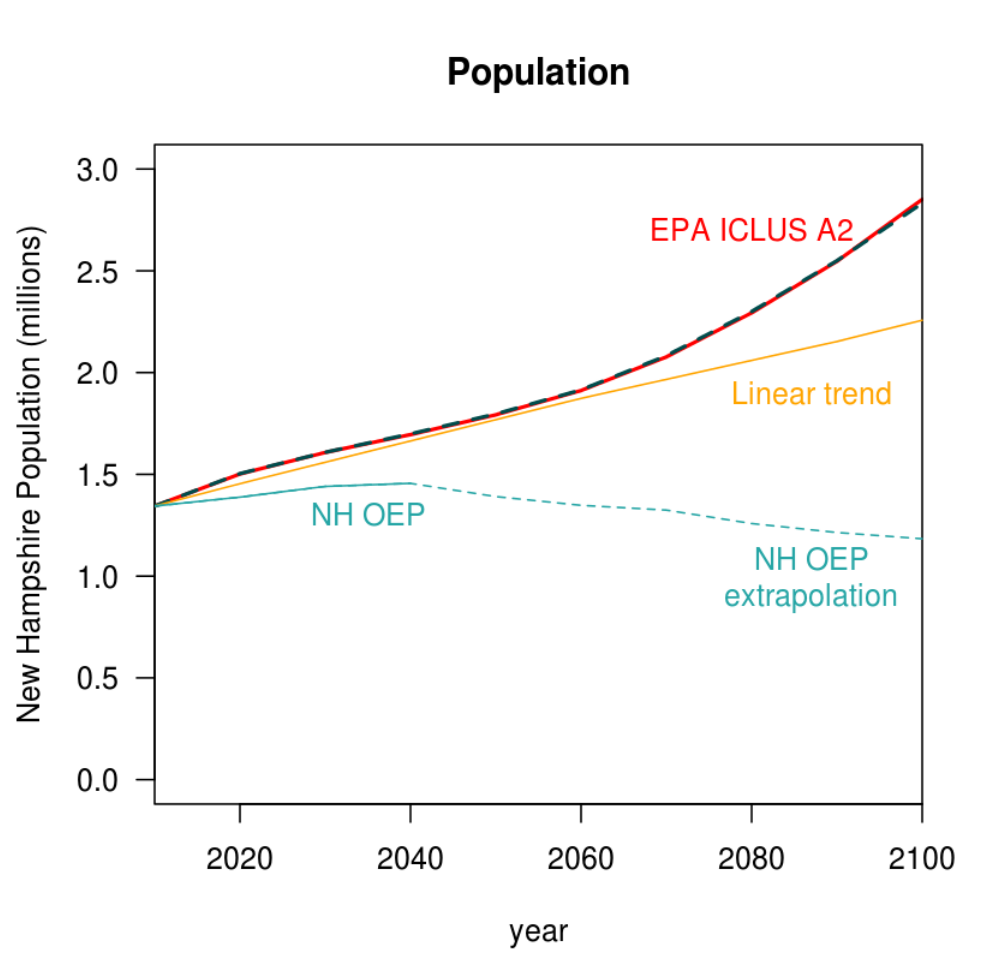
Fig. A2.1. The three New Hampshire population trajectories used in the scenarios: ICLUS A2, the EPA ICLUS population projection for the IPCC A2 scenario (EPA ICLUS), a linear extrapolation of 1990-2010 population trends (Linear trend), and NH Office of Energy and Planning (NH OEP) with projection out to 2100 (NH OEP